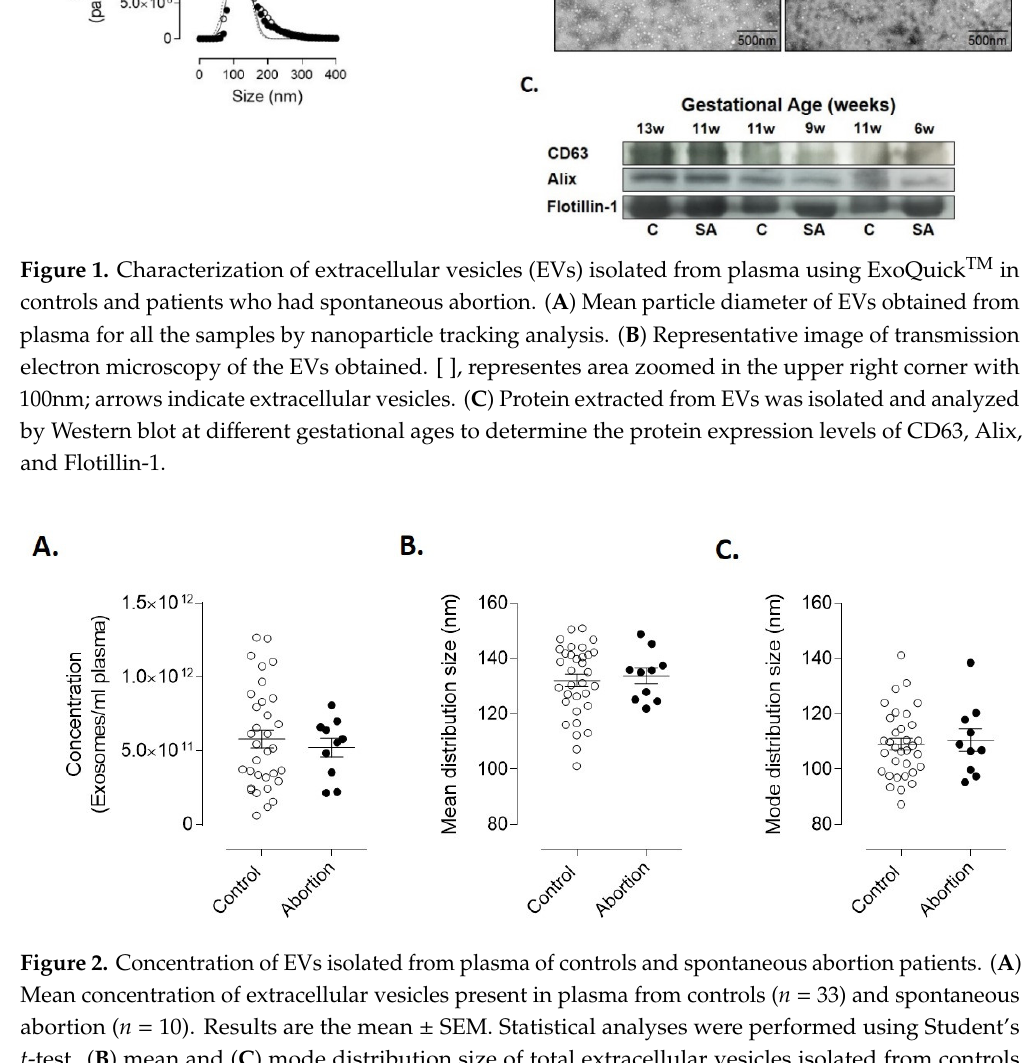
Figure 2. Concentration of EVs isolated from plasma of controls and spontaneous abortion patients. ( A ) Mean concentration of extracellular vesicles present in plasma from controls ( n = 33) and spontaneous abortion ( n = 10). Results are the mean ± SEM. Statistical analyses were performed using Student’s t -test. ( B ) mean and ( C ) mode distribution size of total extracellular vesicles isolated from controls ( n = 33) and spontaneous abortion ( n = 10).